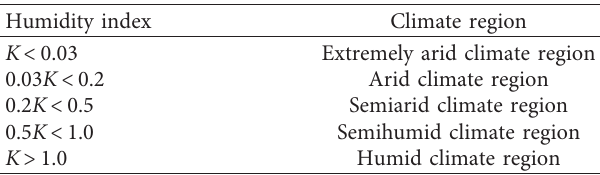
Figure 1: Distribution of meteorological stations in China (a) and the study area (b). Table 2: Humidity index ( K